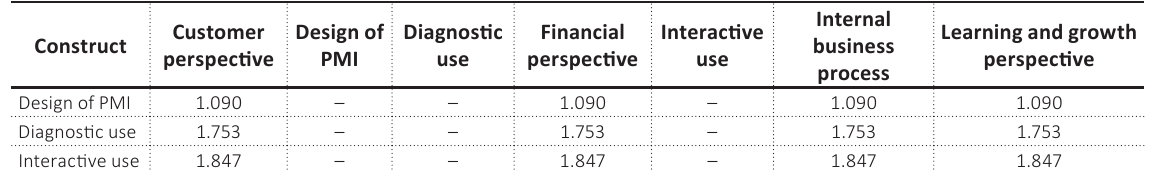
Table 7. Inner Variance Inflation Factor